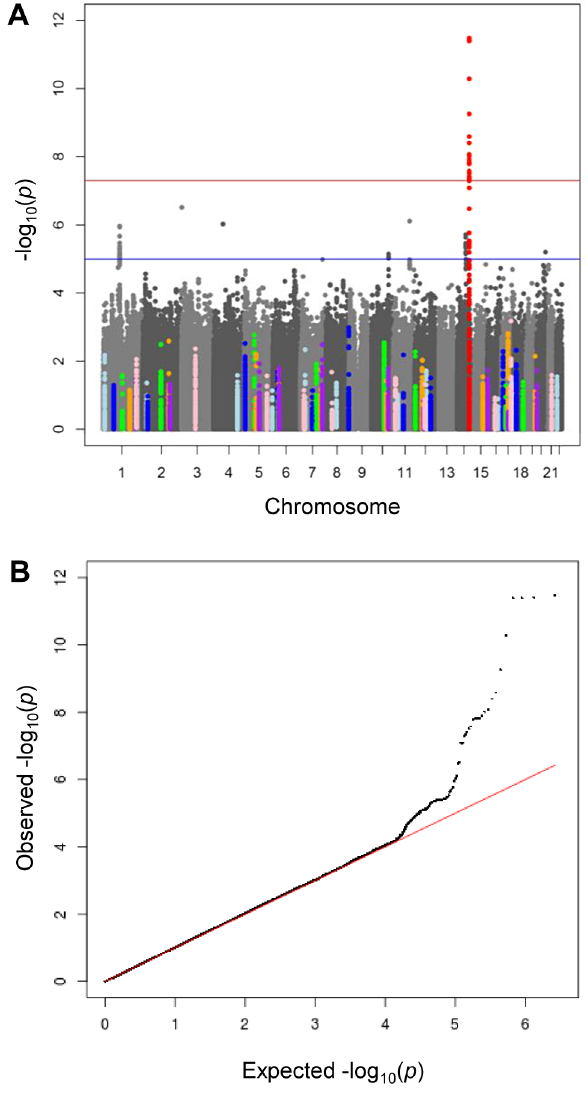
Figure 1. Meta-analysis of genome wide association studies for morning plasma cortisol. A) Manhattan plot of 2 lop 10 P values by chromosome. The red horizontal line indicates genome-wide signifi- cance ( P , 5 6 10 2 8 ) and the blue horizontal line indicates moderate significance ( P , 5 6 10 2 5 ). The lead SNP rs12589136 (chr14:94,793,686; b37) in red is genome-wide significant. SNPs within 6 50 kb of cortisol- related candidate genes (listed in Table S6) are highlighted in colours. B) Quantile-quantile plot of 2 log 10 P , comparing the distribution of observed 2 log 10 P -values and that expected by chance.